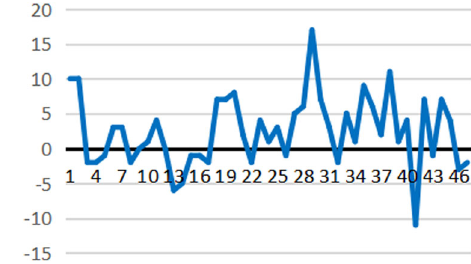
Fig. 5 Frequency increase of common words in two networks. The horizontal axis represents the common words of the two networks and the vertical axis their increased